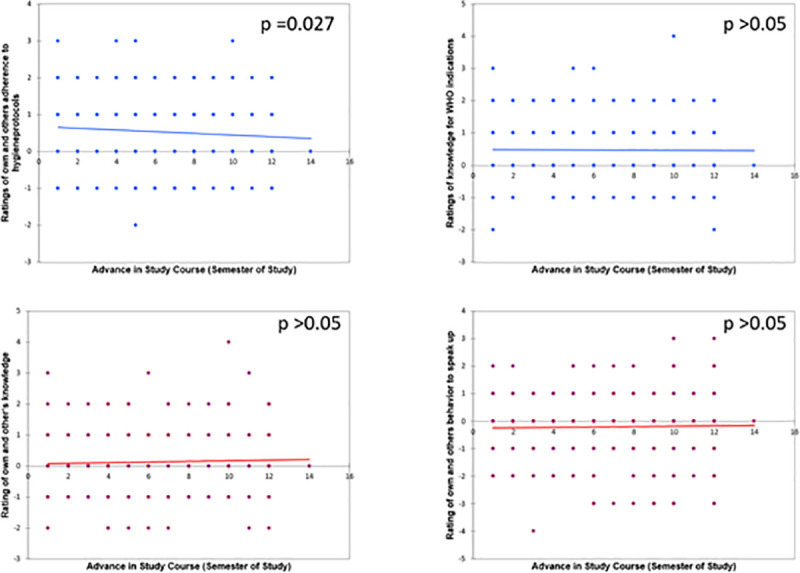
Correlations of the group C for semester (x-axis) and the mathematical difference between estimation of own and others’ competences (y-axis, positive numbers show, that students rated themselves above other, negative that they rated themselves inferior) for adherence to hygiene protocols (upper left, difference of item 10 and 16), knowledge for WHO indications (upper right, items 11 and 17), knowledge about disinfection agents (lower left, items 12 and 18) and the competence to speak up (lower right, items 13 and 19). Blue lines show negative, red positive correlations.